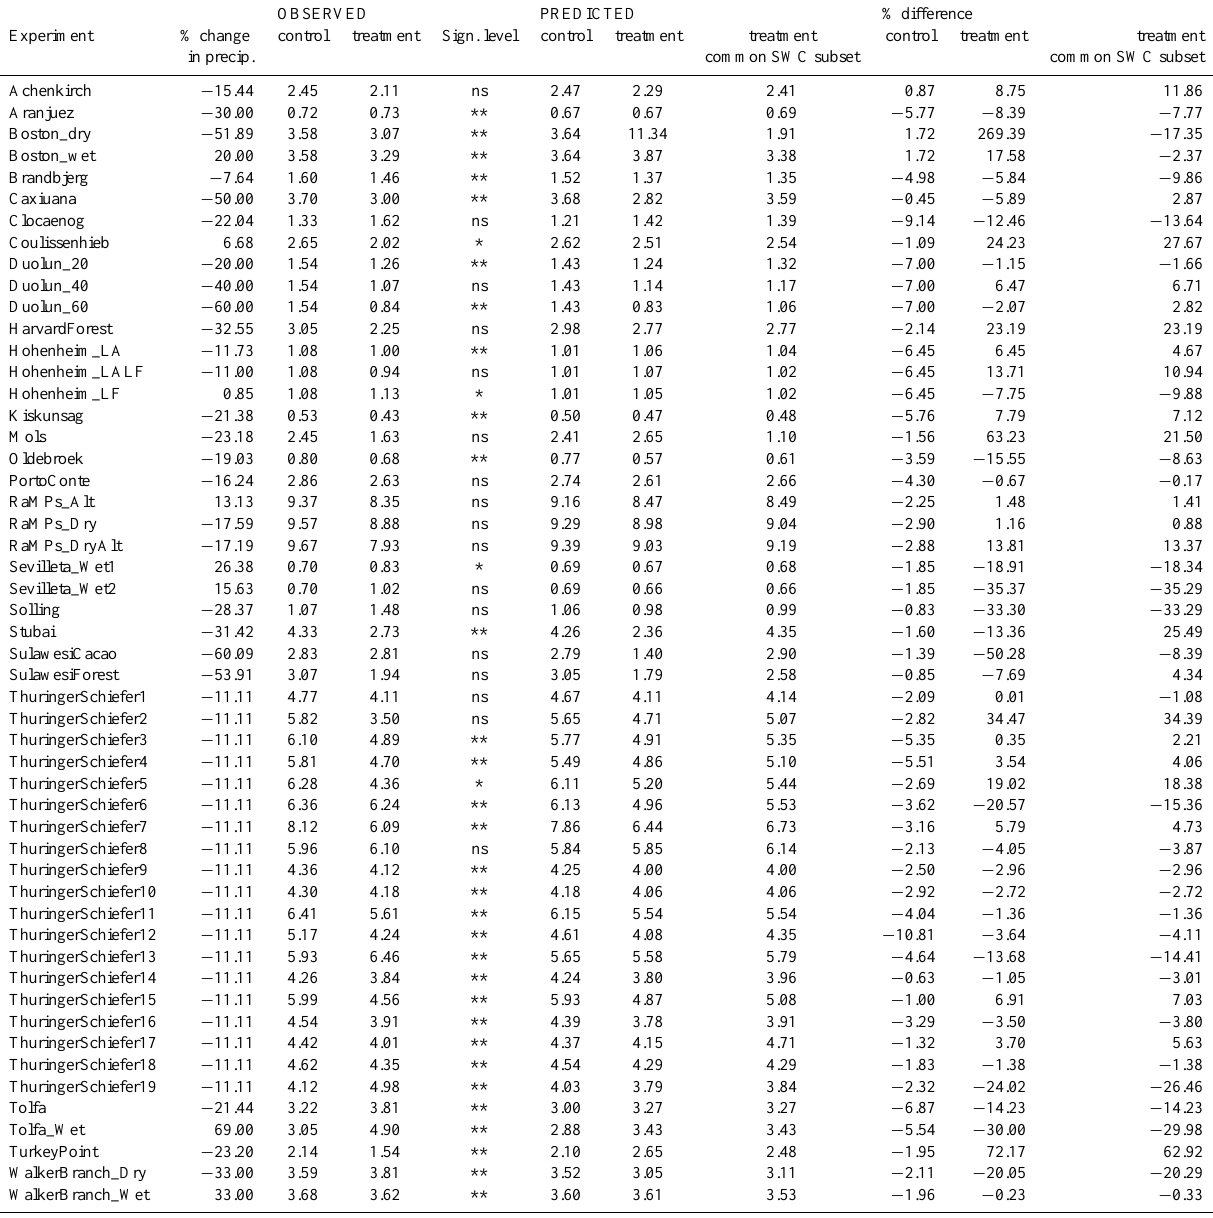
Table B1. For each experiment, the percentage change in precipitation is given, along with the average of observed and predicted soil CO 2 efflux (SCE; µmolCO 2 m − 2 s − 1 ) for control and treatment in all experiments. “Sign. level” indicates whether the difference between treatment and control SCE measurements was significant at p < 0 . 01 (**), at p < 0 . 05 (*) or not significant (ns) according to repeated measures ANOVA. For the treatment, averages are also shown for the subset including only days where SWC treatment is within the range of SWC observed in the control (common SWC subset). Averages were computed over the entire measurement period. Predictions are based on the model parameterized by the control data (model 4; see Methods and Supplement Table S3 for details). The percentage difference between predicted and observed is calculated as 100 · (average predicted – average observed)/average observed. Positive values indicate overestimates, whereas negative values indicate that predicted SCE underestimated observed SCE. The percentage change in precipitation was calculated from precipitation data, averaged for the entire duration of the experiment. Negative values indicate a reduction of precipitation, while positive numbers indicate an increase in